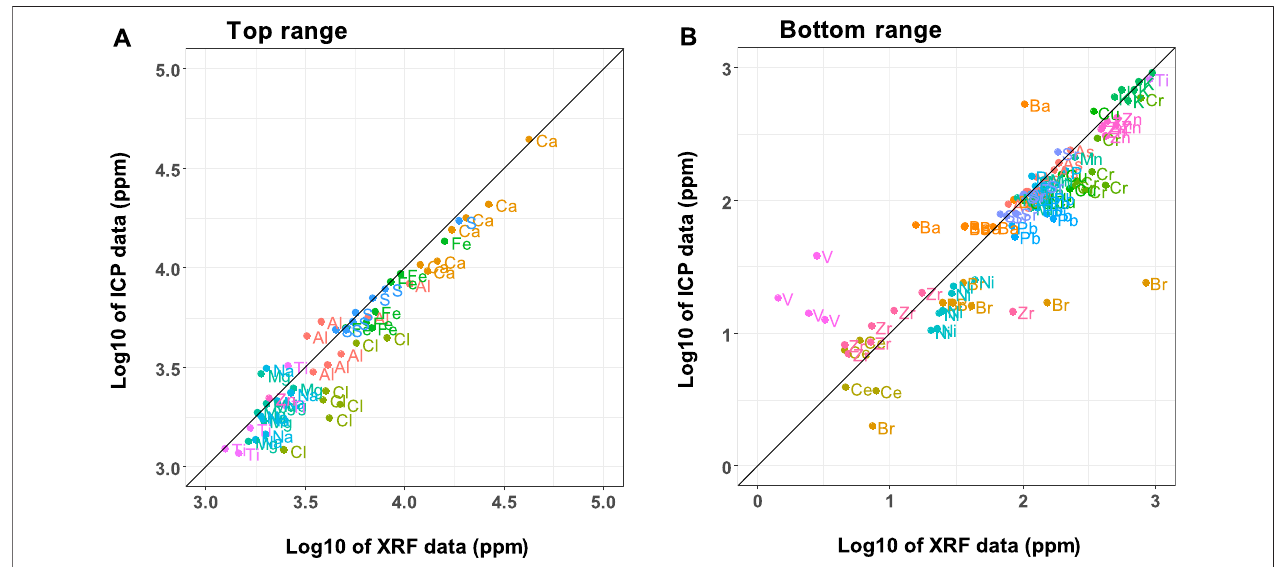
FIGURE 7 | Comparison of mineral element data from UH XRF and Hazen ICP analyses across two concentration ranges, (A) > 1,000 ppm and (B) < 1,000 ppm (ICP data do not include chlorine and sulfur).